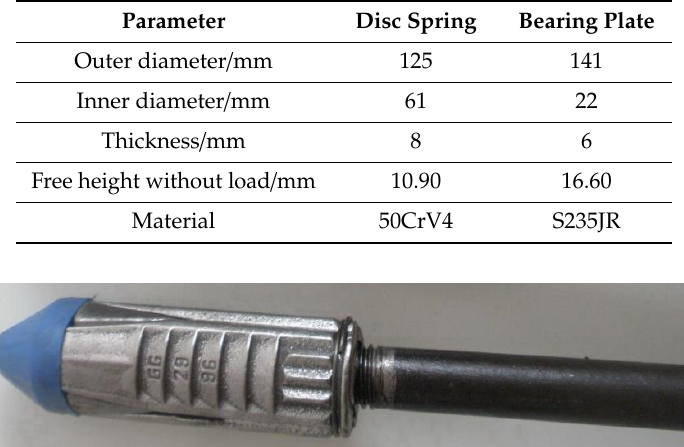
Figure 7. Bolt rod with an expansion head.